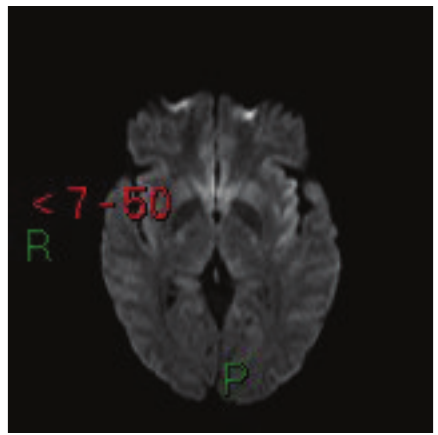
Figure 6: Case 3. Axial diffusion-weighted MRI: lesions showed a slight signal